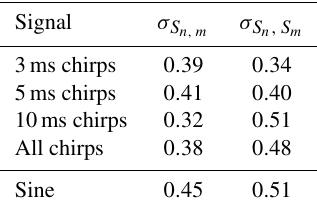
Table 4. Estimated values for the relative systematic uncertainties σ S and σ S for the chirp measurements. For comparison, the n,m n ,S m results from the sine burst measurements are also listed.